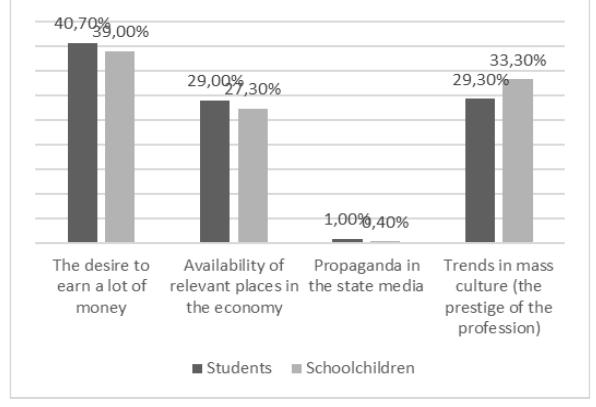
Figure 6. Reasons for choosing a career